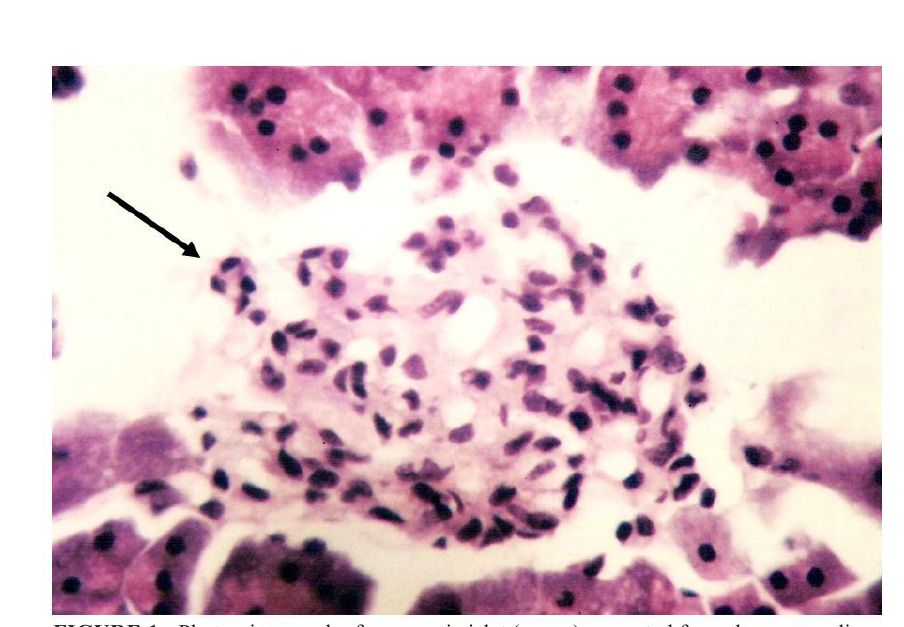
FIGURE 1 - Photomicrograph of pancreatic islet (arrow) separated from the surrounding exocrine tissue, after pancreatic tissue preparation (Hematoxilin and Eosine;